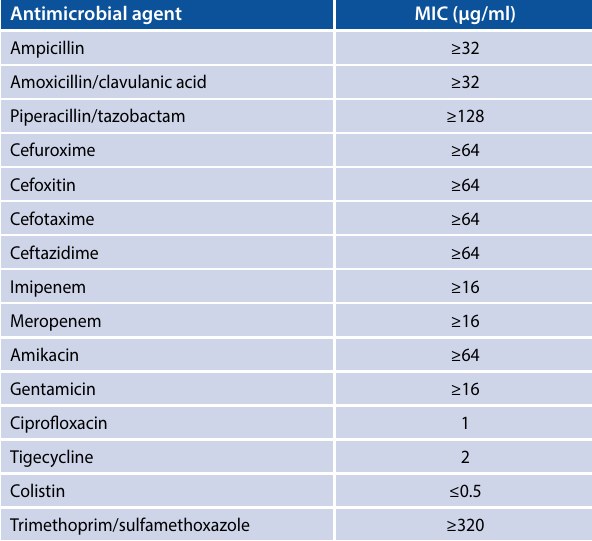
Table 1: Antibiogram of Raoultella ornithinolytica Antimicrobial